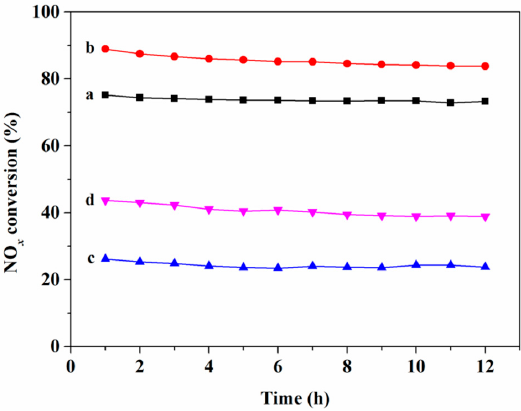
Figure 1. NO x conversion of ( a ) VWTi, ( b ) VWCeCuTi, ( c ) VWTi-S and ( d ) VWCeCuTi-S.